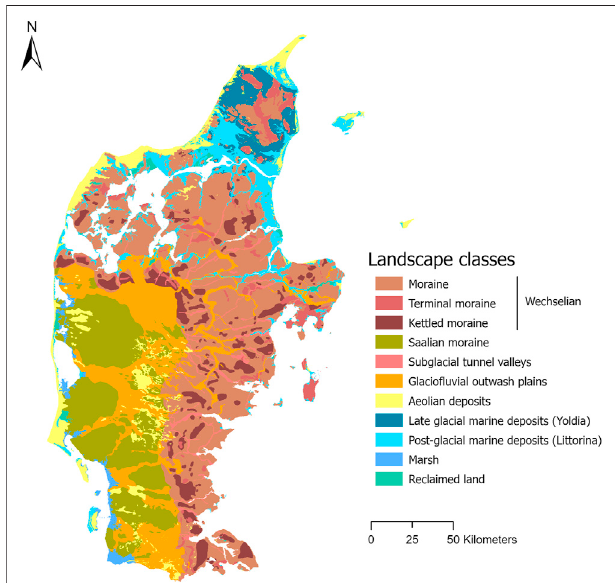
FIGURE 7 | Map of the main landscape types (i.e., spatially homogeneous geomorphological units) in Jutland (derived using the existing digital vector landscape map at 1:100000 scale originally from Madsen et al. (1992)).